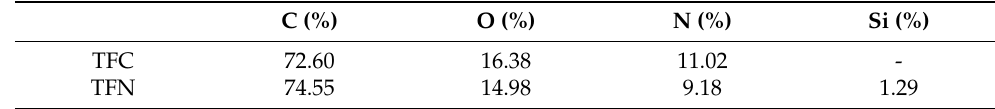
Figure 2. ATR-FTIR spectra of hPAN, TFC, and TFN membranes: ( a ) wavenumber from 4000 to 650 cm − 1 ; ( b ) wavenumber from 1400 to 650 cm − 1 . Table 1. Elemental compositions of TFC and TFN membranes.